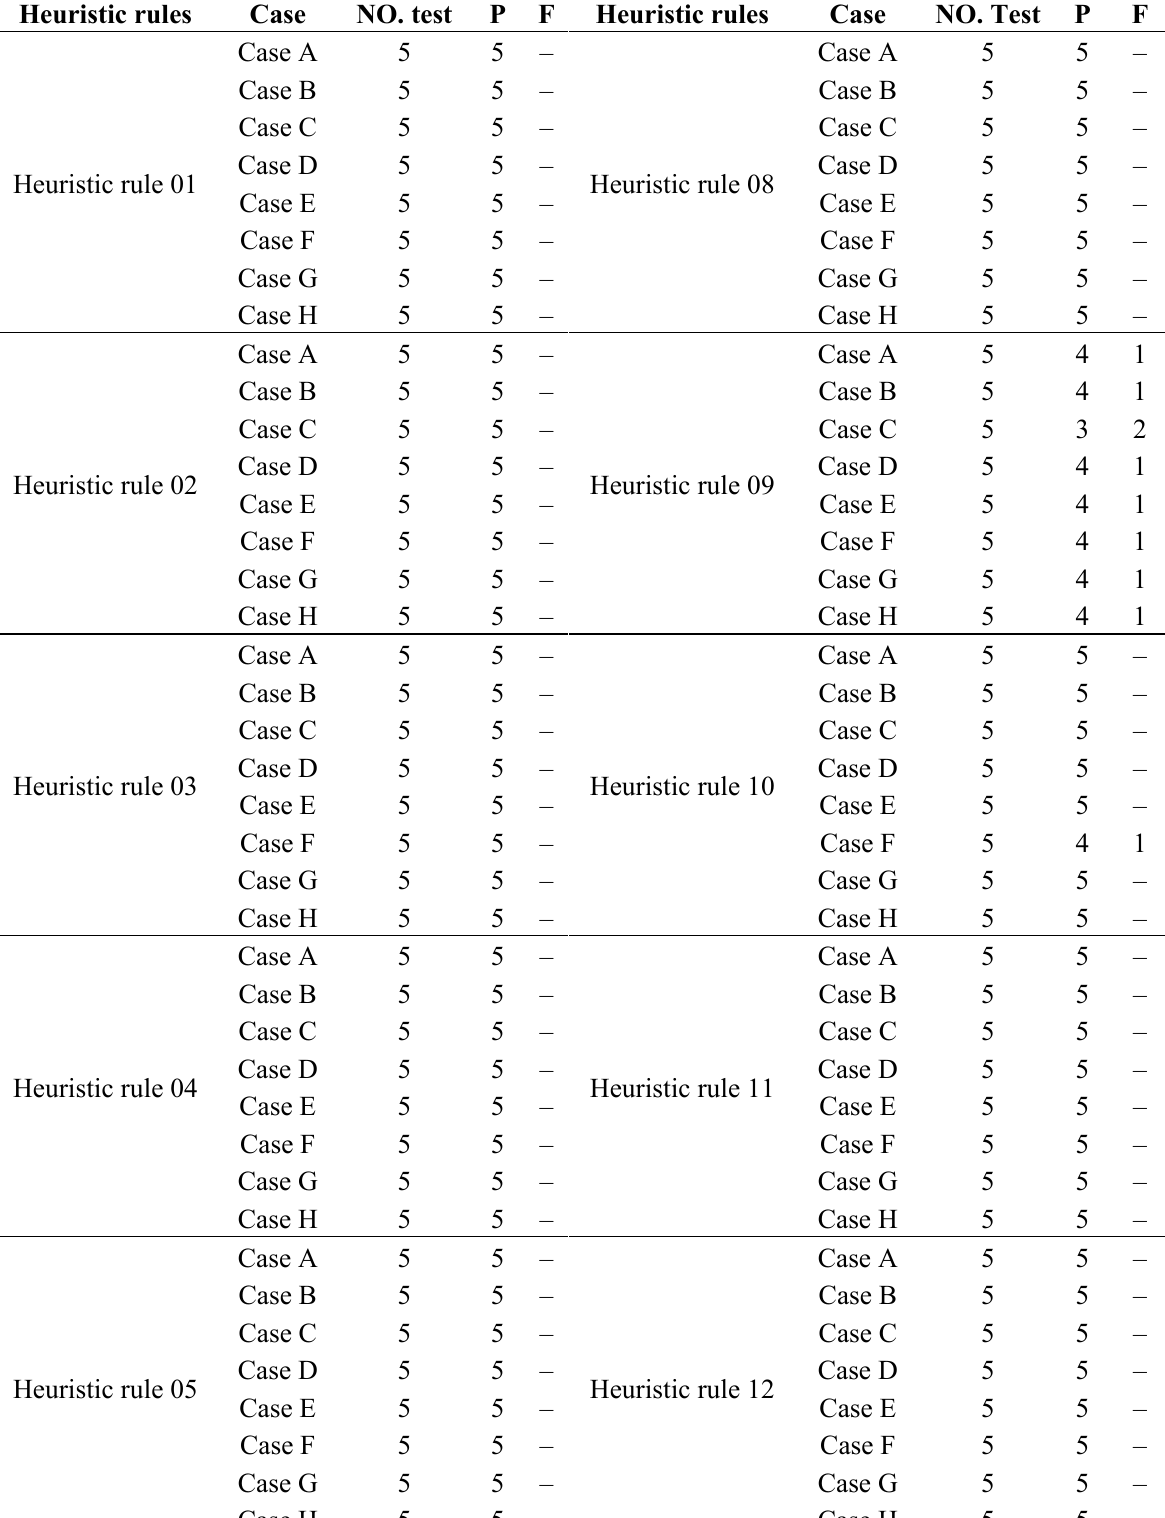
Table 15. The evaluation result for heuristic